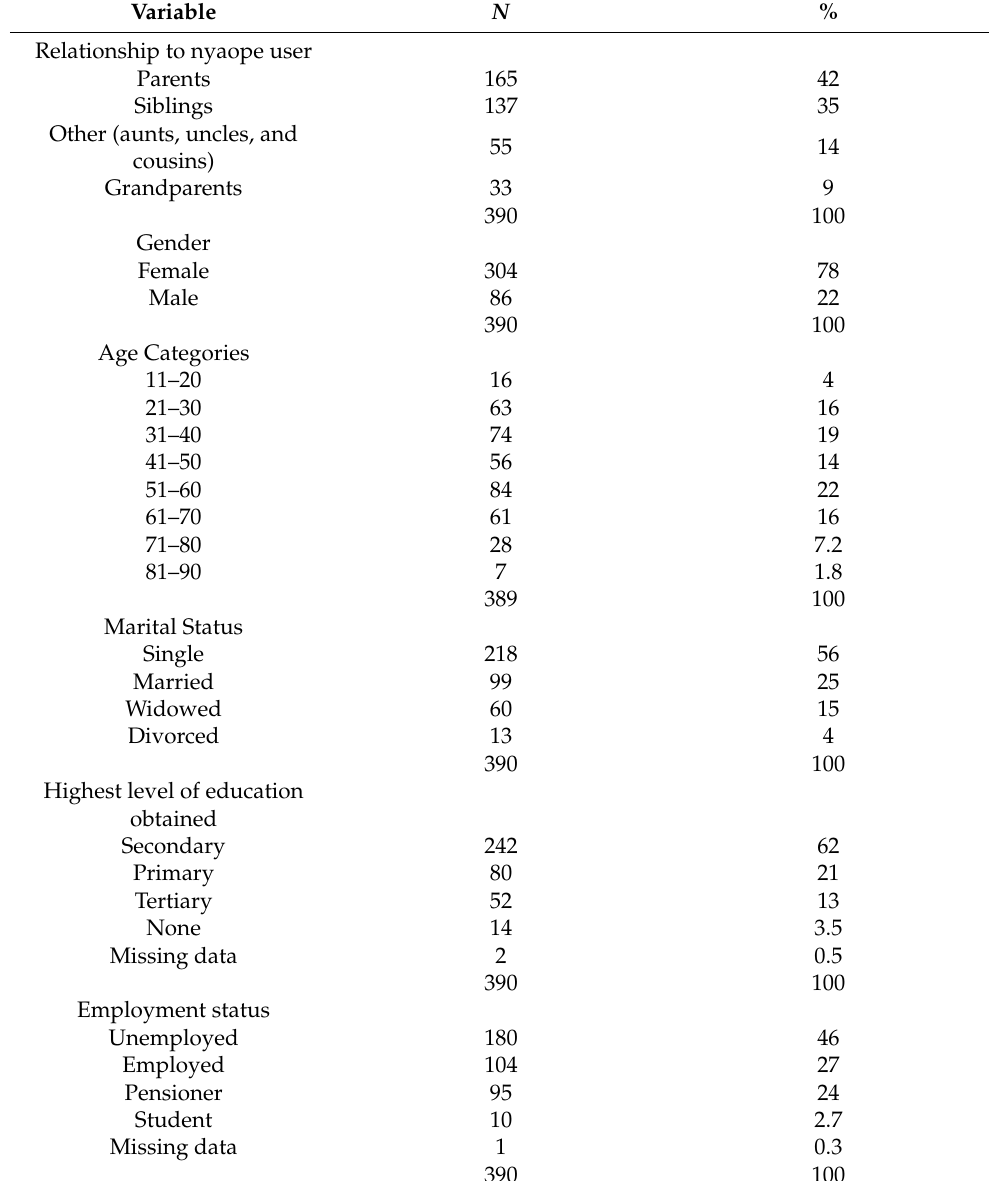
Table 1. Demographic profiling of families with a nyaope